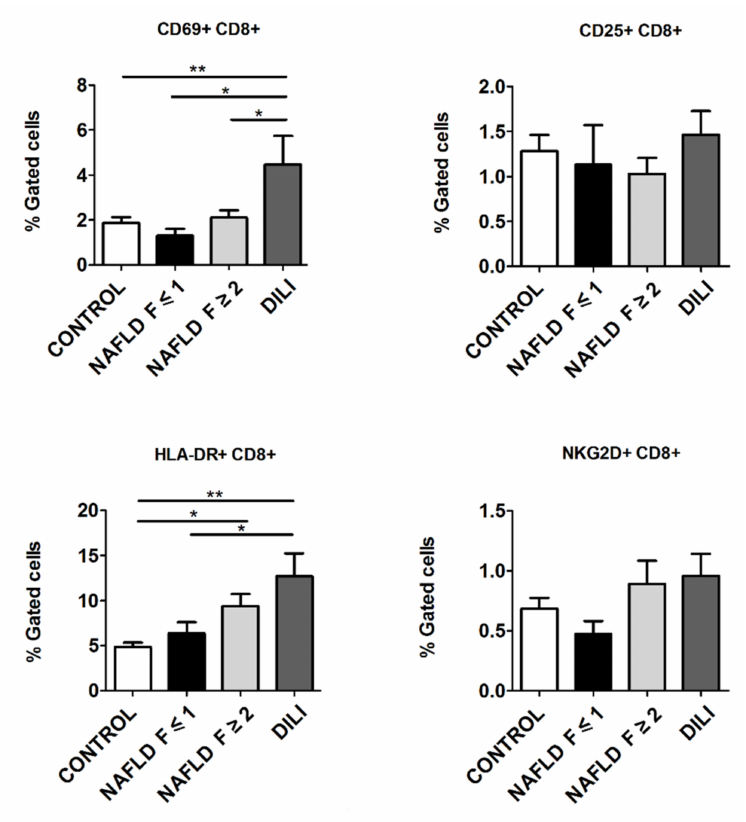
Figure 4. Expression of early (CD69+) and late (CD25+, HLA-DR+) activation markers, and NKG2D+ in CD8+ T cells in T lymphocytes from peripheral blood mononuclear cells from healthy controls, non-alcoholic fatty liver disease (NAFLD) and drug-induced liver injury (DILI) patients. Data are presented as mean ± standard error of the mean. * p ≤ 0.05, ** p ≤ 0.001. In addition, HLA-DR+CD8+ T cells were significantly increased in DILI patients (12.6 ± 2.6) compared to NAFLD patients without significant liver fibrosis (F ≤ 1) (6.9 ± 1.1, p = 0.045) and healthy controls (5.0 ± 0.5, p < 0.001) (Figure 4). Besides, a significant increase was found in NAFLD patients with significant liver fibrosis (F ≥ 2) with regard to healthy controls (9.0 ± 1.3 vs. 5.0 ± 0.5, p = 0.006) (Figure 4). However, no significant differences were found in the percentage of CD25+CD8+ and NKG2D+CD8+ T cells among groups (Figure 4). 3.7. Correlations between the Activation Profile of Lymphocytes with Anthropometric/Biochemical Variables and Fatty Liver and Fibrosis Index Positive moderate correlations (r > 0.4) were found between CD69+iNKT and AST (r = 0.43, p = 0.003) (Figure 5A), and between HLA-DR+CD8+ and ALP (r = 0.45, p = 0.001) (Figure 5B). Notably, there were marginal low-to-moderate correlations (0.35 < r < 0.4) between CD69+iNKT and either insulin (r = 0.37, p = 0.037) and HOMA-IR (r = 0.35, p = 0.049), between HLA-DR+CD4+ and ALP (r = 0.39, p = 0.005), and between HLA- DR+CD8+ and AST (r = 0.36, p = 0.015). The remaining correlations are shown in Figure